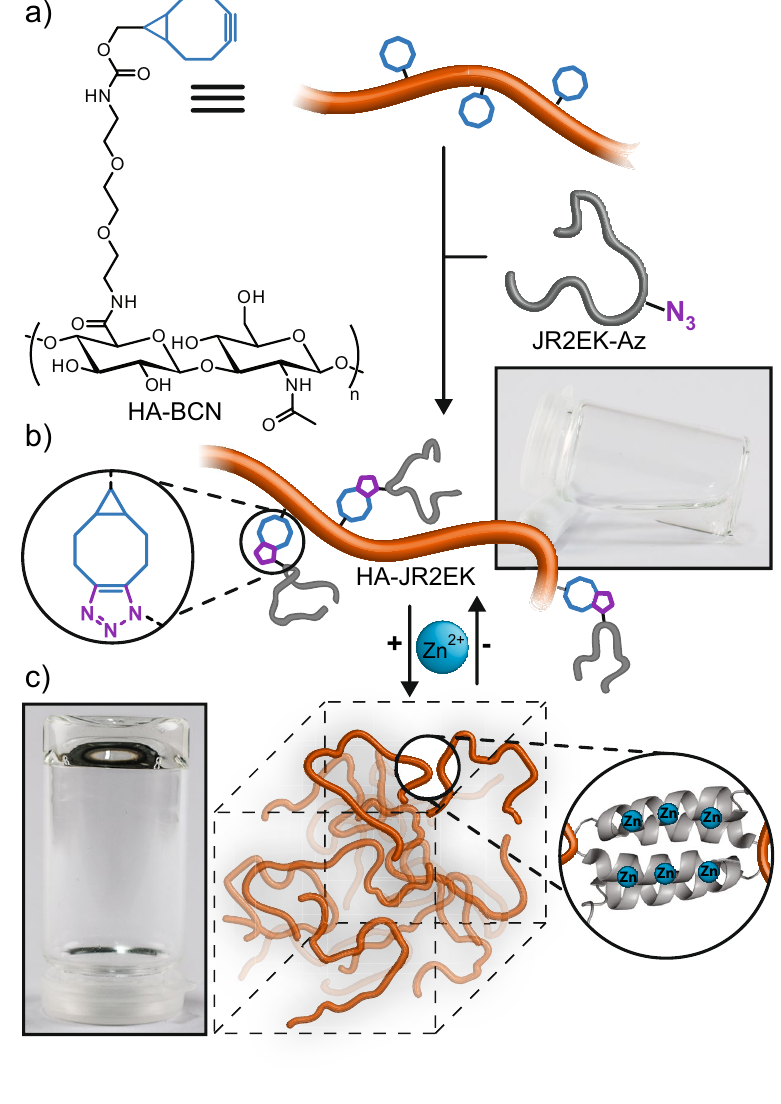
Figure 1. ( a ) Molecular structure and schematic illustration of HA-BCN that, when combined with the peptide JR2EK-Az, undergoes a SPACC reaction forming the responsive hybrid material HA-JR2EK. ( b ) The peptide component in HA-JR2EK exists as a random coil until addition of Zn 2 + which causes it to fold and dimerize, resulting in a supramolecular cross-linking and self-assembly of a hydrogel ( c ). Removal of Zn 2 + returns the peptides in HA-JR2EK to a random coil state and triggers disassembly of the hydrogel. Photographs of 2.5 wt % HA-JR2EK without (top) and with (bottom) 10 mM Zn 2 +